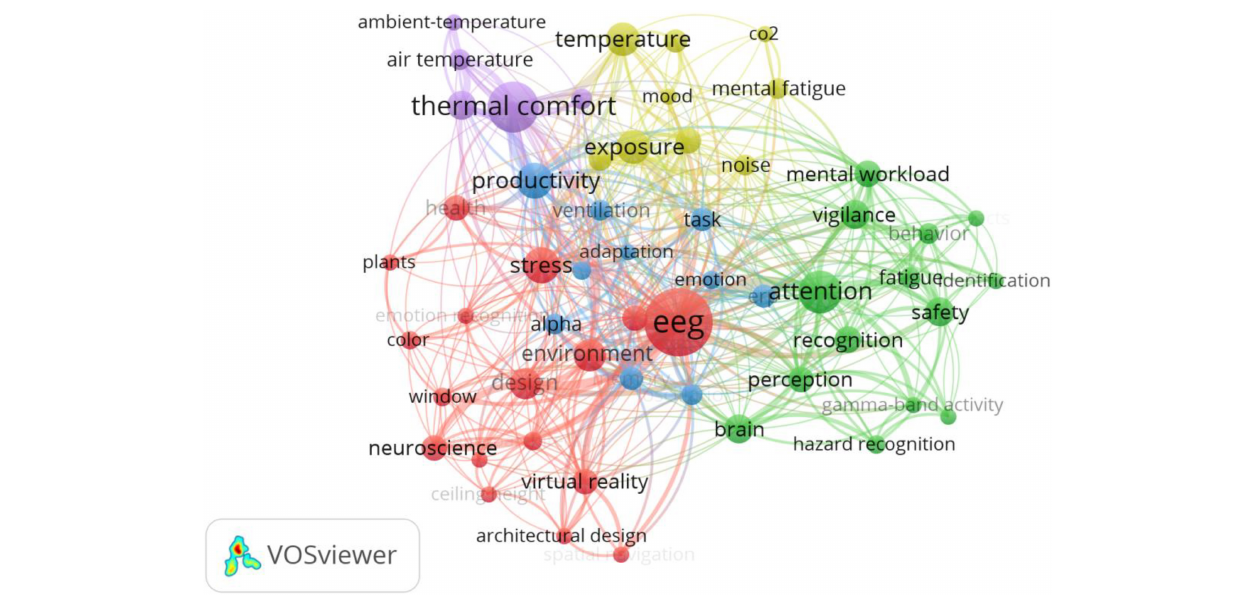
FIGURE 10 | Keywords co-occurrence network of EEG/ERP in building construction.